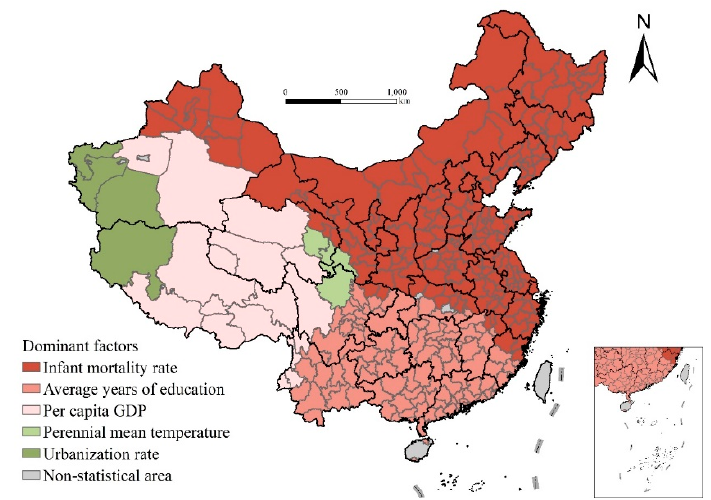
Figure 9. Spatial distribution of the dominant factors affecting life expectancy at birth.